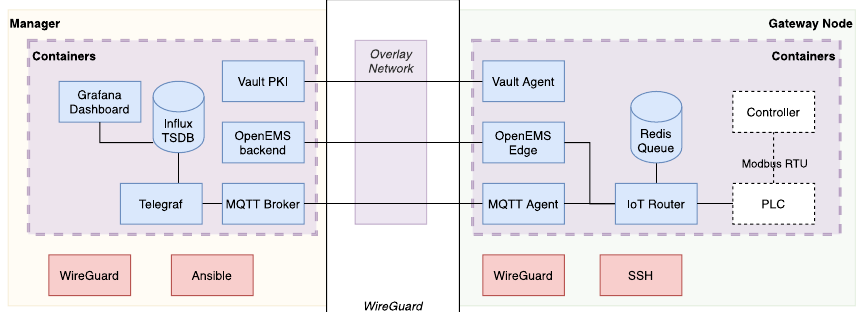
Fig. 5 Testbed software architecture. Red boxes are services running directly on the operating system, blue boxes are services which run in containers. White dashed boxes are emulated functions, which in this case also run in a